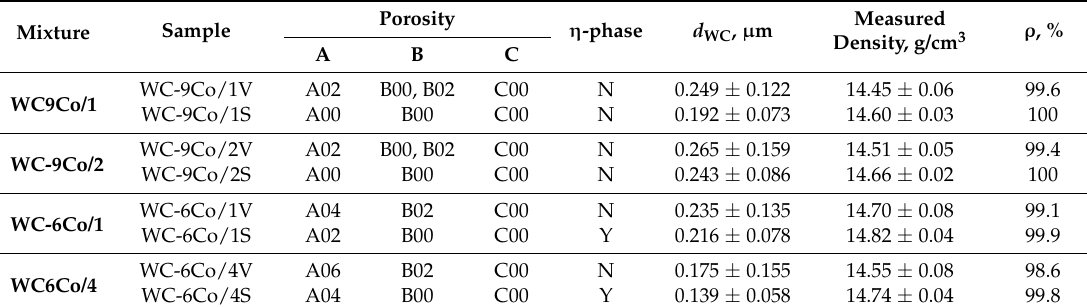
Table 2. Characteristics of researched samples